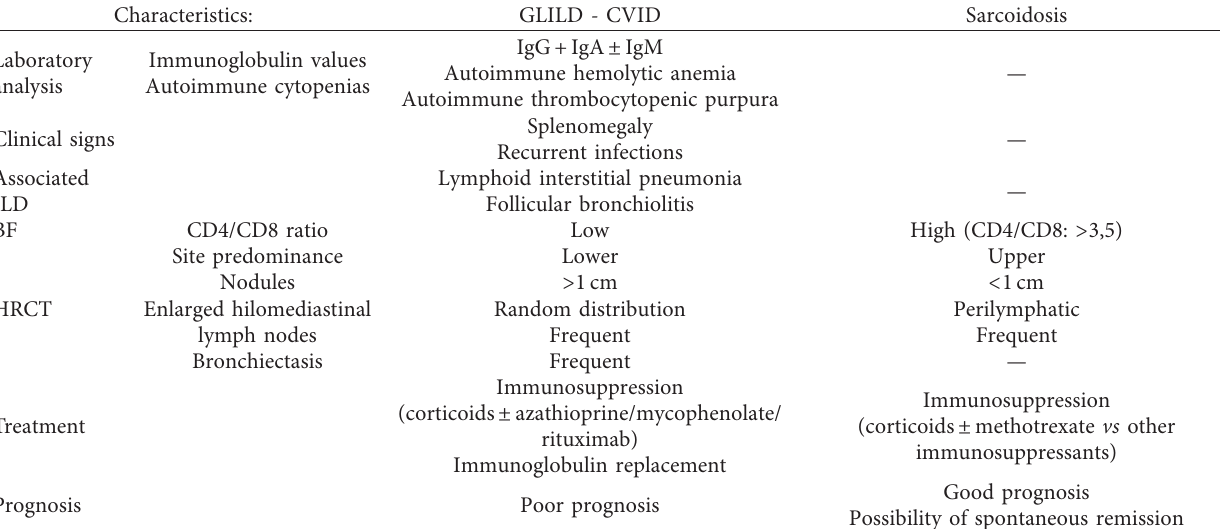
Table 3: Differential characteristics of GLILD vs